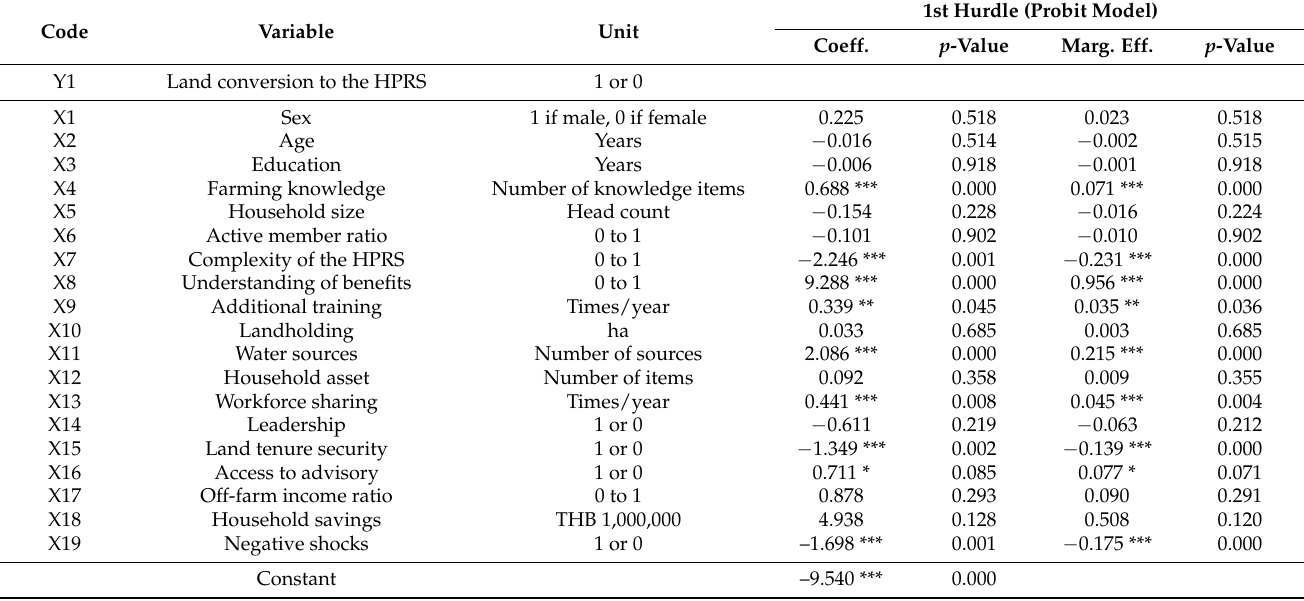
Table 7. The first-hurdle probit estimates of the determinants of the likelihood of farmland conversion to the